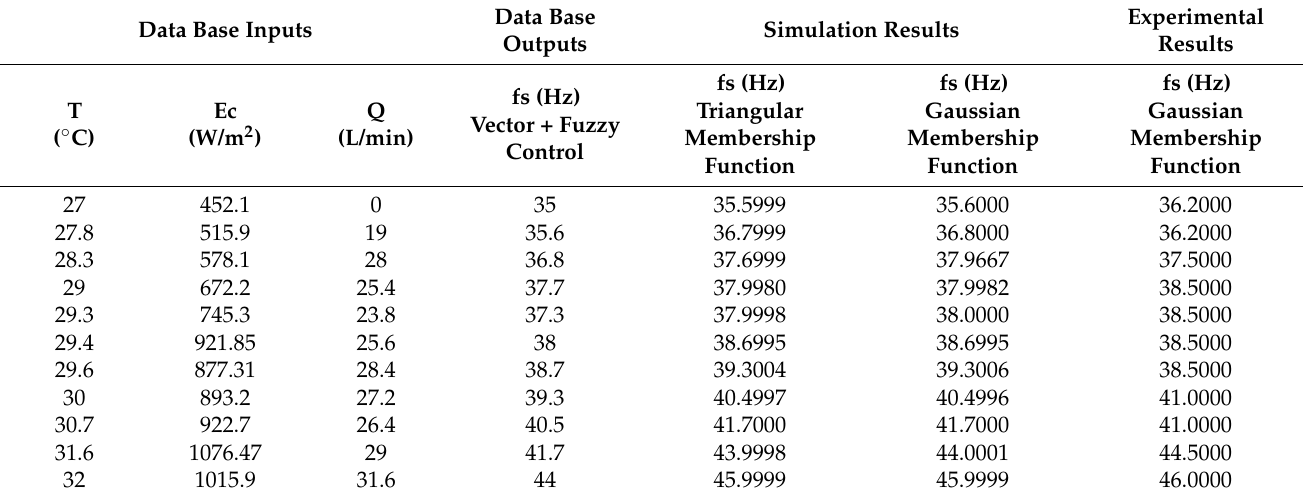
Table 1. Comparative